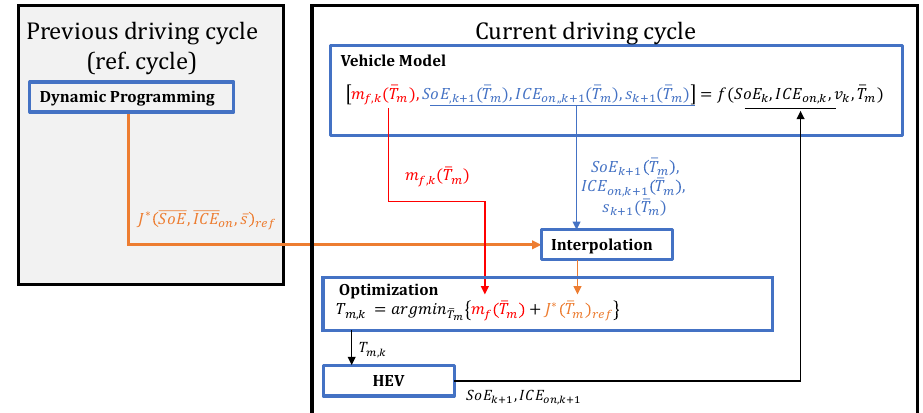
Figure 7. Block diagram of the proposed